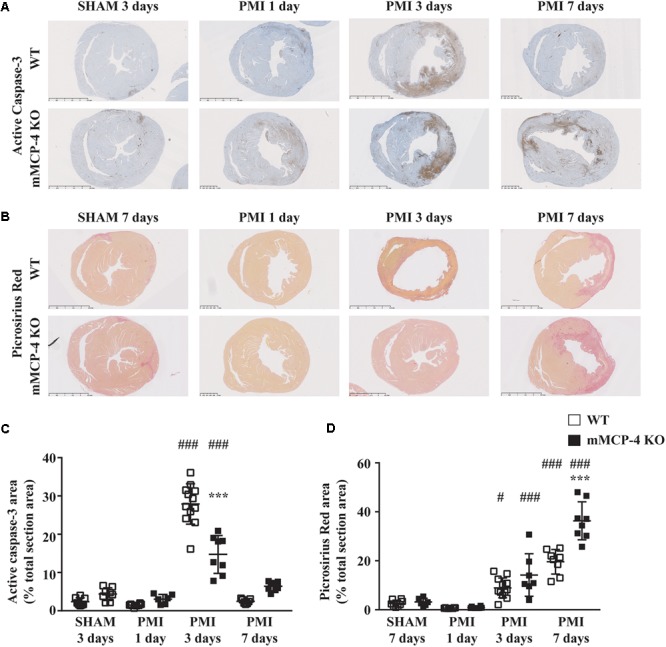
Representative active caspase-3 (A) and collagen deposition (B) of heart sections following LAD coronary artery ligation or SHAM surgery. Active caspase-3 DAB (brown) staining [quantified in (C)] is visible against the hematoxylin (blue) counterstain, while collagen deposition [quantified in (D)] is marked by the picrosirius red stain. (#: PMI vs. SHAM, ∗: mMCP-4 KO vs. WT, one-way ANOVA with multiple comparisons Holms-Šidak post-test).